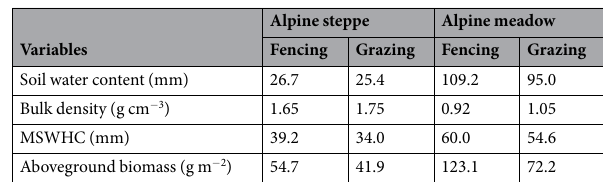
Table 1. Summary of long-term fencing effect on ecosystem characteristics on two alpine grasslands. Shown are soil properties: soil water content in the top 40 cm, bulk density, and Maximum Soil Water Holding Capacity (MSWHC); and aboveground biomass on the two typical alpine grasslands (steppe and